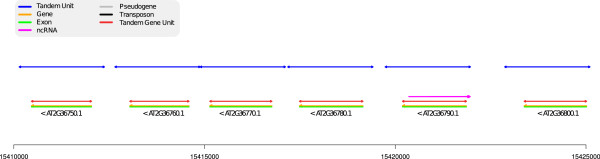
A typical example of a detected TGA. Region 15,410,000-15,425,000 of chromosome 2. Genes are indicated in green/yellow (exons/introns). Reference TGUs are indicated in red. The blue regions represent the detected TUs. The TGA is perfectly detected: each TU precisely corresponds to one TGU. The dotplot of this region is represented on the left of Figure 1. There are 666 TA similar to this one (all TUs detect TGUs of a TGA).